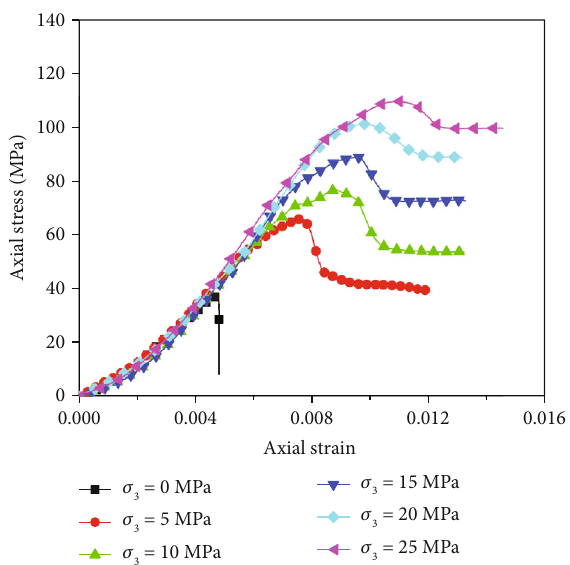
− ε curves of triaxial compression tests. Figure 3: σ 1